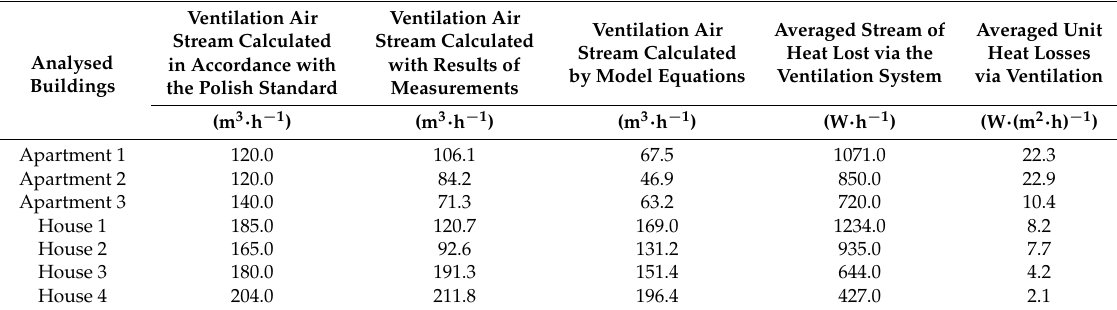
Table 3. Defined ventilation air streams and heat loss for the buildings analysed.